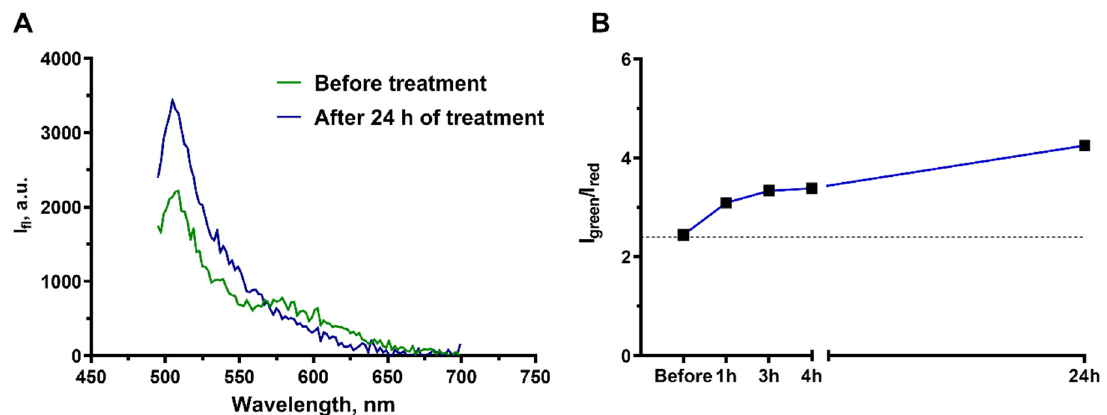
Figure 6. Monitoring of the apoptosis development in the culture of A431-Casper3GR cells treated with 100 μ M cisplatin. ( A ) Spectra of fluorescence emission of collagen hydrogel with embedded A431-Casper3GR cells before and 24 h after cisplatin addition to the medium. ( B ) Change in the I green /I red ratio of the Casper3-GR fluorescence at different time intervals after the addition of cisplatin.